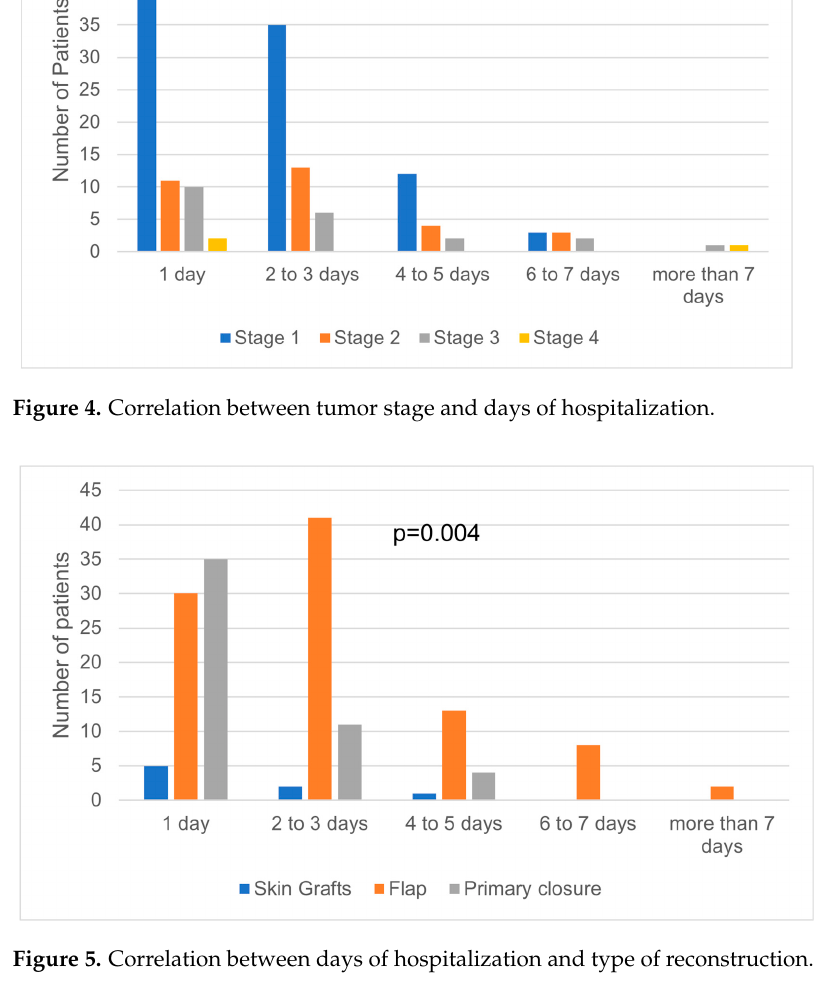
Figure 5. Correlation between days of hospitalization and type of reconstruction.